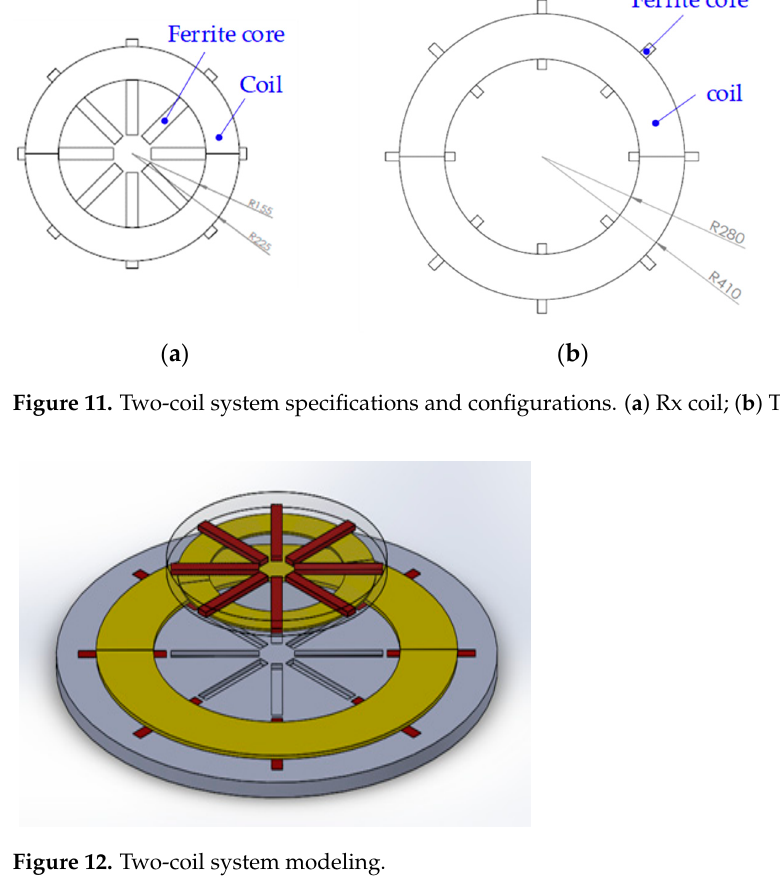
Figure 10. Prototype of the full-bridge series resonant converter. ( a ) Transmission module; ( b ) re- ceiver module.